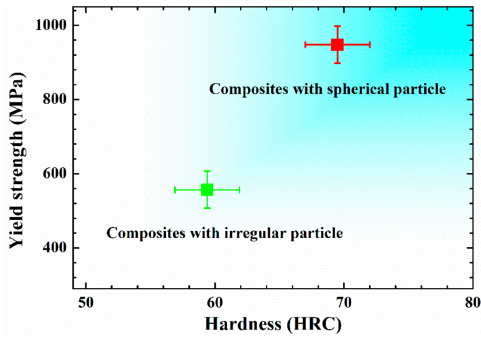
Figure 4. The mechanical properties of WC p /iron matrix composites with different particle shape. The error bars in this figure are the 1/2 intervals of the deviation of the minimum and maximum value.